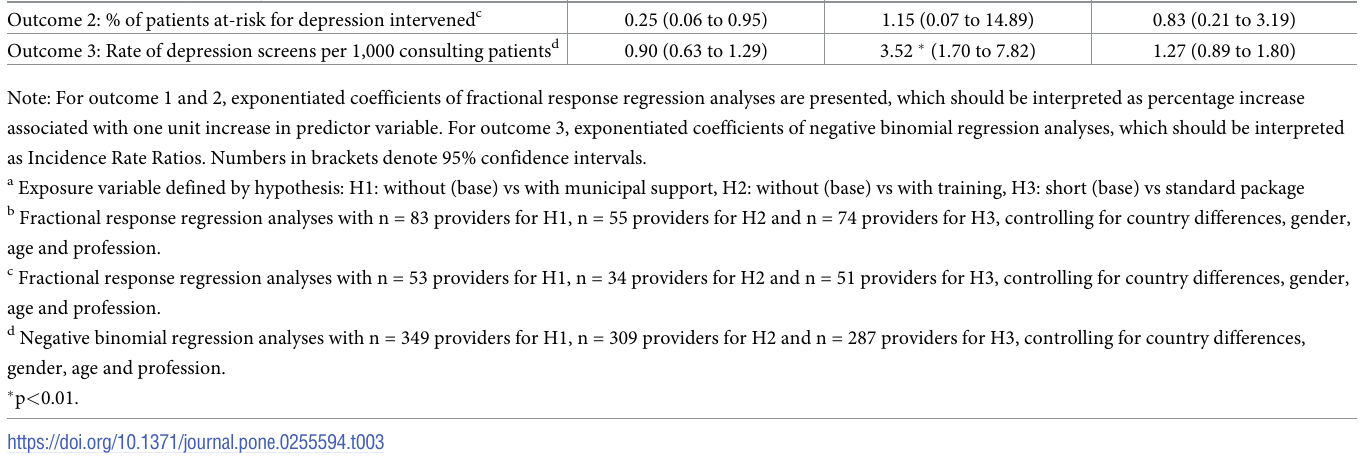
additional analyses, models testing for interaction effects showed no improved data fit. Thus, for outcome 1, we find no support for hypotheses 1 and 2 but accept hypothesis 3.